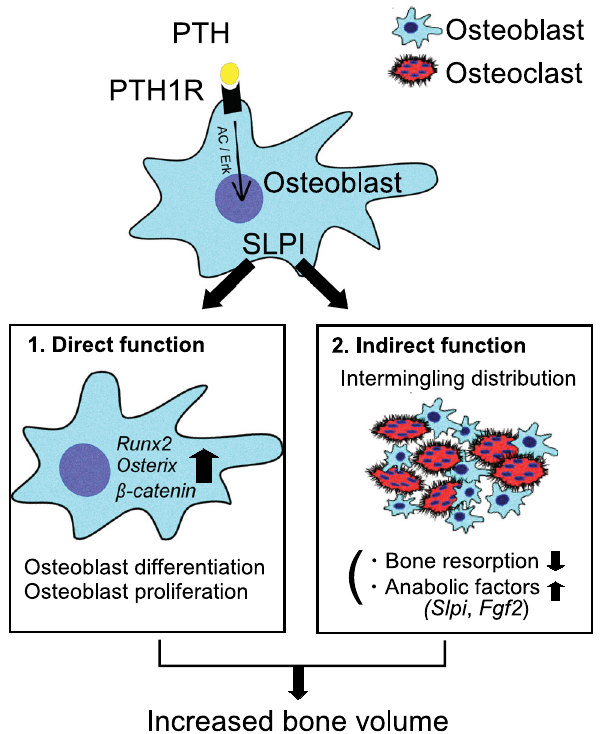
Fig. 5 Model of SLPI functions in bone metabolism. Parathyroid hormone (PTH) binding to parathyroid hormone 1 receptor (PTH1R) upregulates SLPI expression via the pathways of adenylyl cyclase (AC)/protein kinase A, and Erk. SLPI directly acts in osteoblasts to enhance bone formation by controlling gene expression. Additionally, SLPI promotes the adhesion of osteoblasts to neighboring osteoclasts, thereby increasing direct cell – cell contact. This indirect effect creates a microenvironment in the reversal phase, leading to stimulation of Slpi and Fgf2 expression in osteoblasts, and inhibition of osteoclastic bone For RNA-seq and qPCR analysis, 12-week-old female Col2.3-ECFP mice were treated with PTH and evaluated at 1 day, 1 week, and 3 weeks later. Osteoblasts were harvested at 24h after the fi nal injection of intermittent PTH For continuous PTH administration, osmotic pumps (1004; Alzet, Cupertino, CA, USA) were placed subcutaneously between the shoulder blades. Human PTH (1 – 34) (40 µg/kg body weight per day) was infused with pumps for the indicated period 63 .